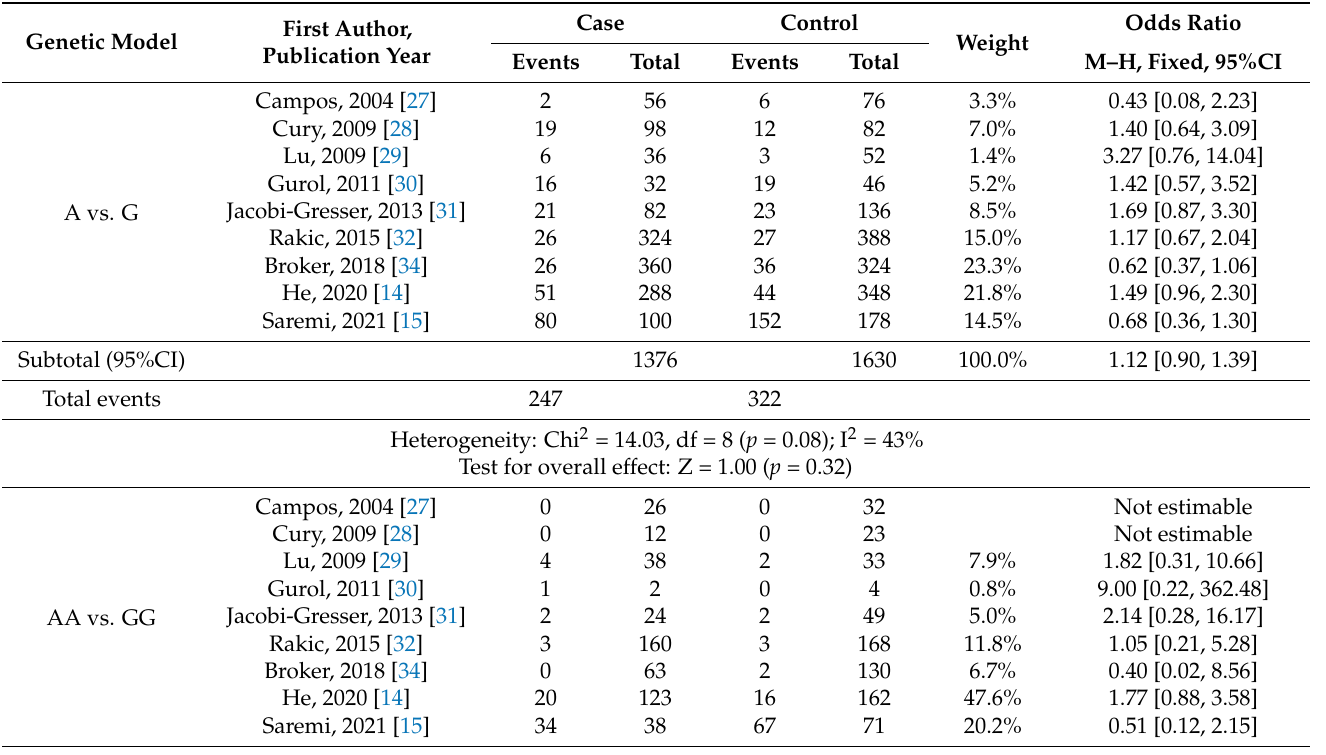
Table 3. The results of meta-analyses based on five genetic models for TNF- α ( − 308 G > A) polymorphism. Genetic Model